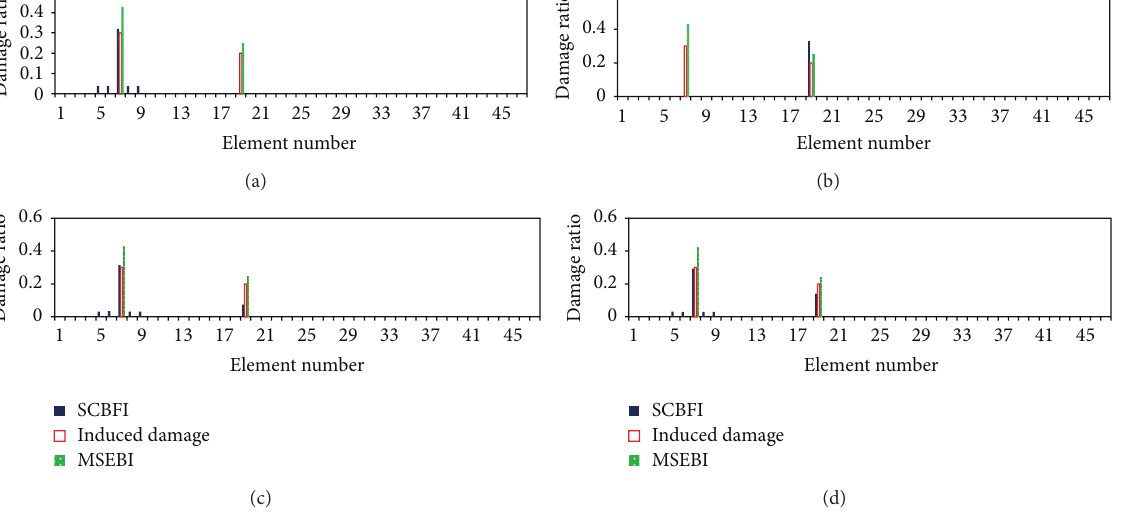
Figure 10: Comparison of damage index SCBFI with MSEBI for 47-bar planar truss for case 2 considering (a) 1 mode, (b) 2 modes, (c) 3 modes, and (d) 4